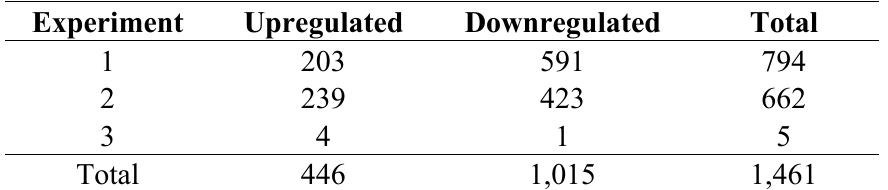
Table 1. Number of honey bee genes displaying different expression levels in response to green fluorescent protein-derived double-stranded RNA (dsRNA-GFP) treatment during worker development. Genes with significant expression levels at FDR < 0.5 (Experiment 1) and adjusted p < 0.05 (Experiments 2 and 3) are